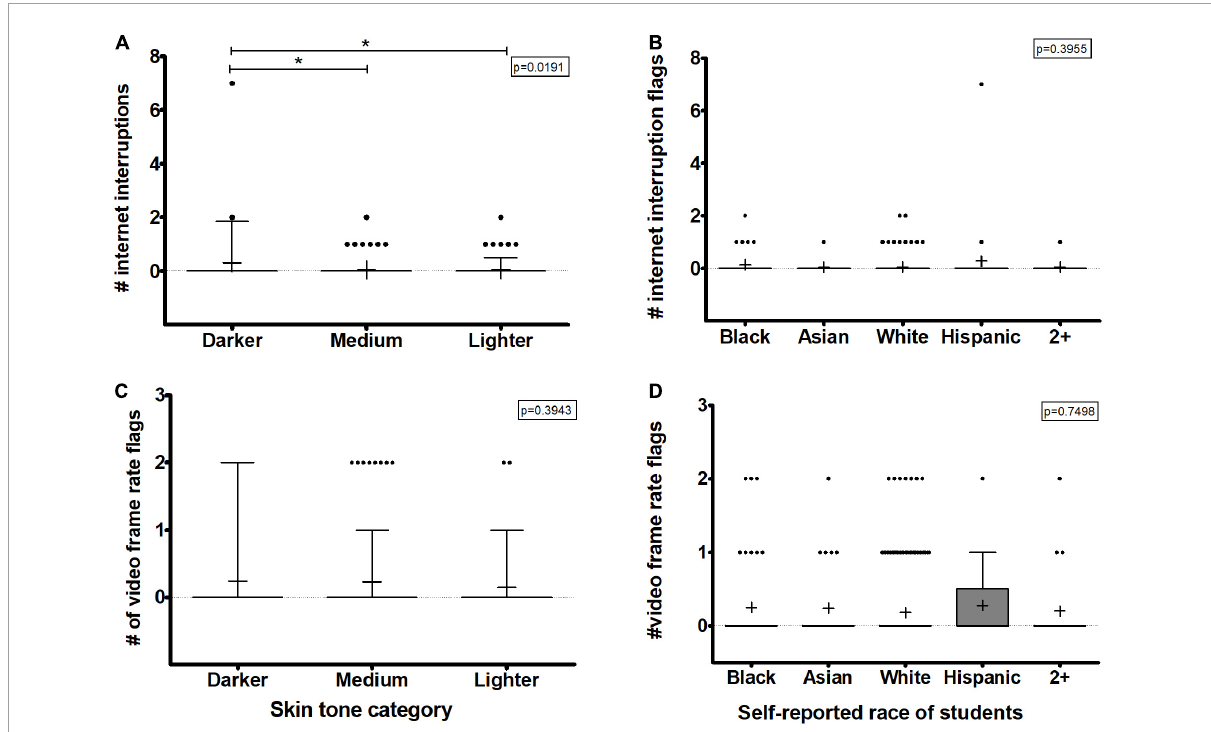
FIGURE3 Internet issues such as interruptions or low speeds outputs from the automated test proctoring software based on skin tone analysis or self-reported race. (A,B) The number of internet interruption flags given to students. (C,D) The number of video frame rate reduction flags for each student. (A,C) Show the data analyzed based on skin tone categories while (B,D) show the data based on self-reported race. Box plots represent 25 and 75% confidence intervals with whiskers represent Tukey’s distributions and dots represent data outliers. Lines inside the boxes represent the median values and + indicate the mean values. Note the divided y -axis scales on some plots to accommodate the wide range of values. Kruskal Wallis tests yielded an overall p -values indicated on each plot with Dunn’s post-test pairwise comparisons shown with brackets (* p >